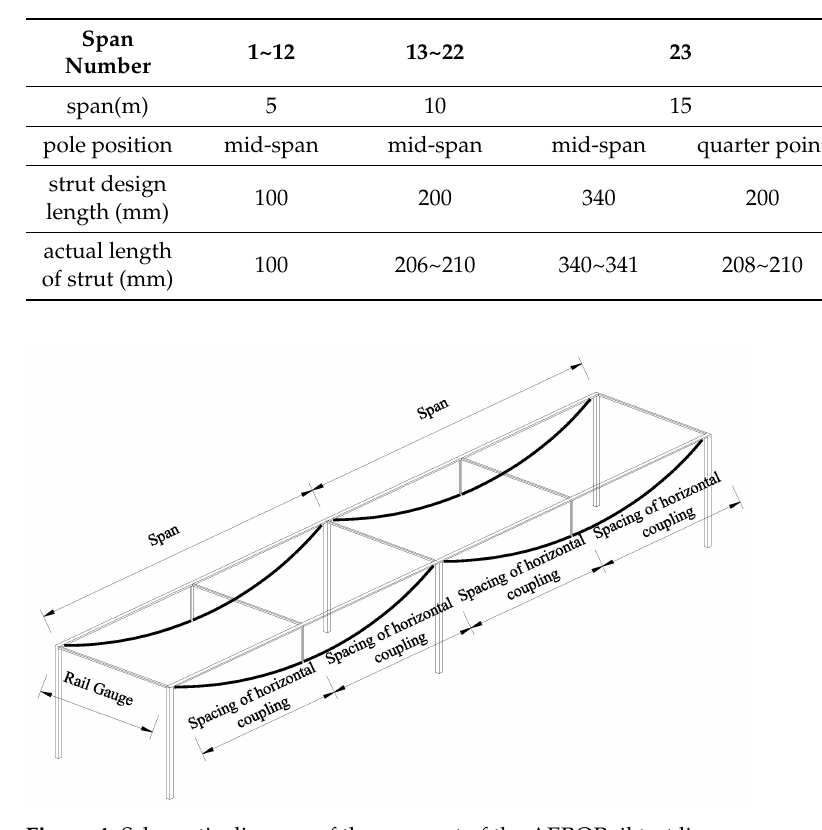
Figure 4. Schematic diagram of the segment of the AERORail test